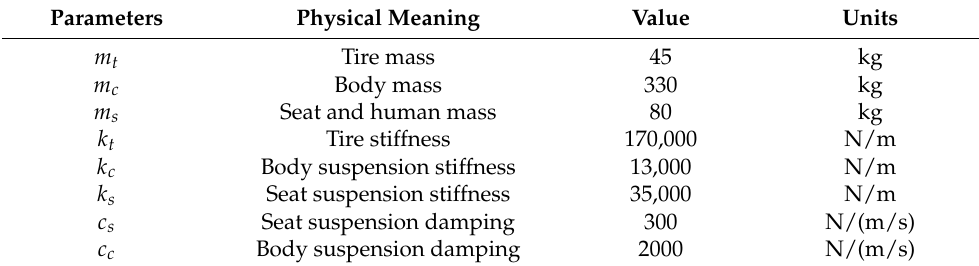
Table 1. Simulation parameters of seat suspension.